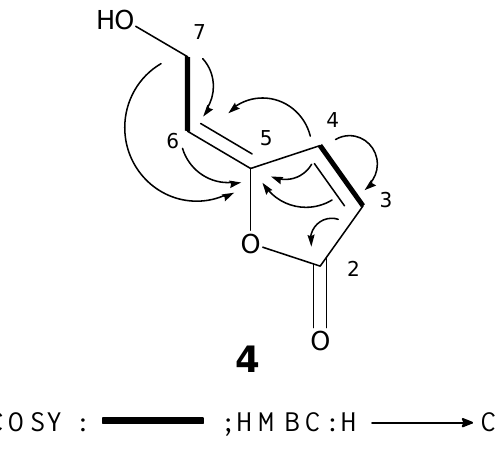
Figure 3. COSY and HMBC correlations of compound 4